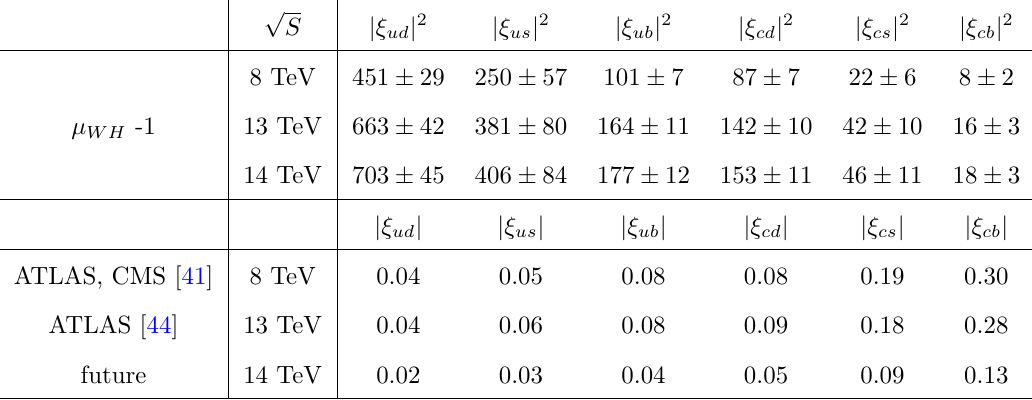
Table 2 . Signal strength for the WH production channel at 90% CL bounds on (cid:24) ij . The projected bounds at 14 TeV assume 20% uncertainties on (cid:22) WH